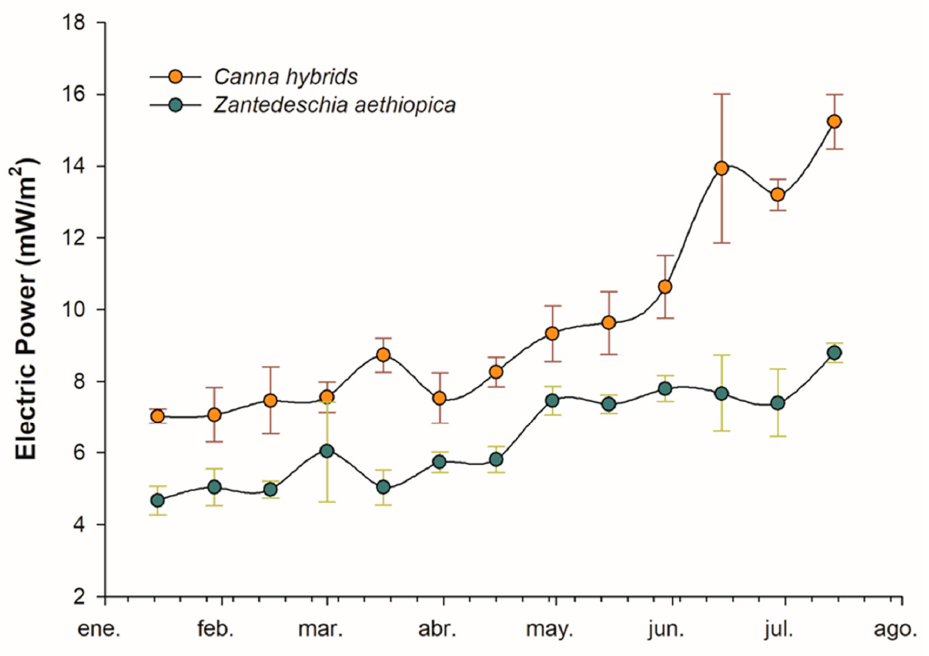
Figure 4. Comparison of maximum power (mW/m 2 ) generated in VPS-CW systems using Canna hybrids and Z. aethiopica during 8 months of retention. Table 1. Physicochemical parameters of input and output in VPS-CW systems with Z. aethiopica and Canna hybrids